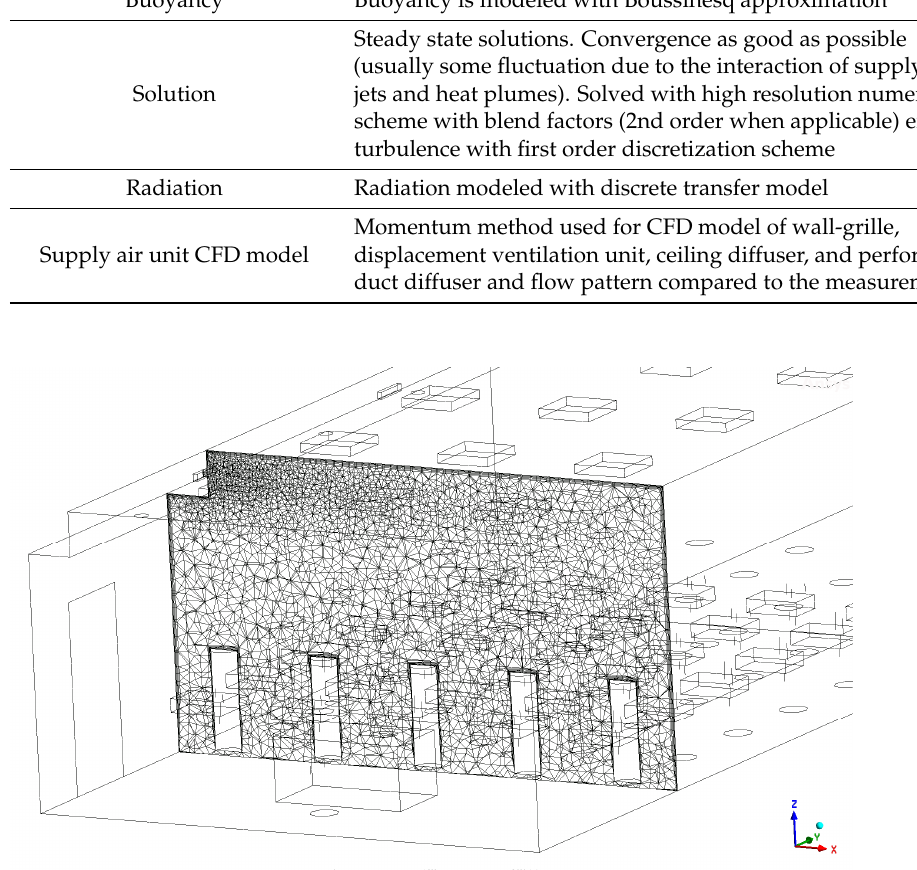
Figure 3. The grid density level with the wall ‐ grille.